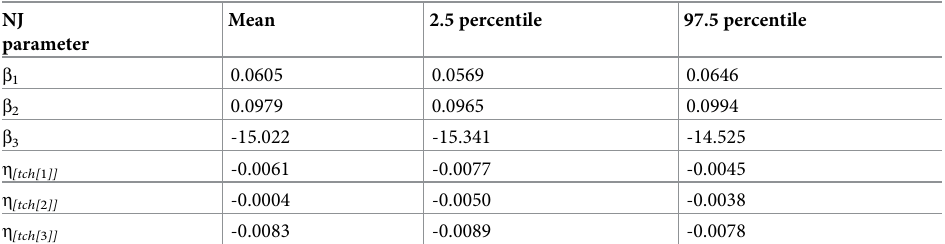
Table 12. Posterior mean parameter estimates for the NJ mobility model